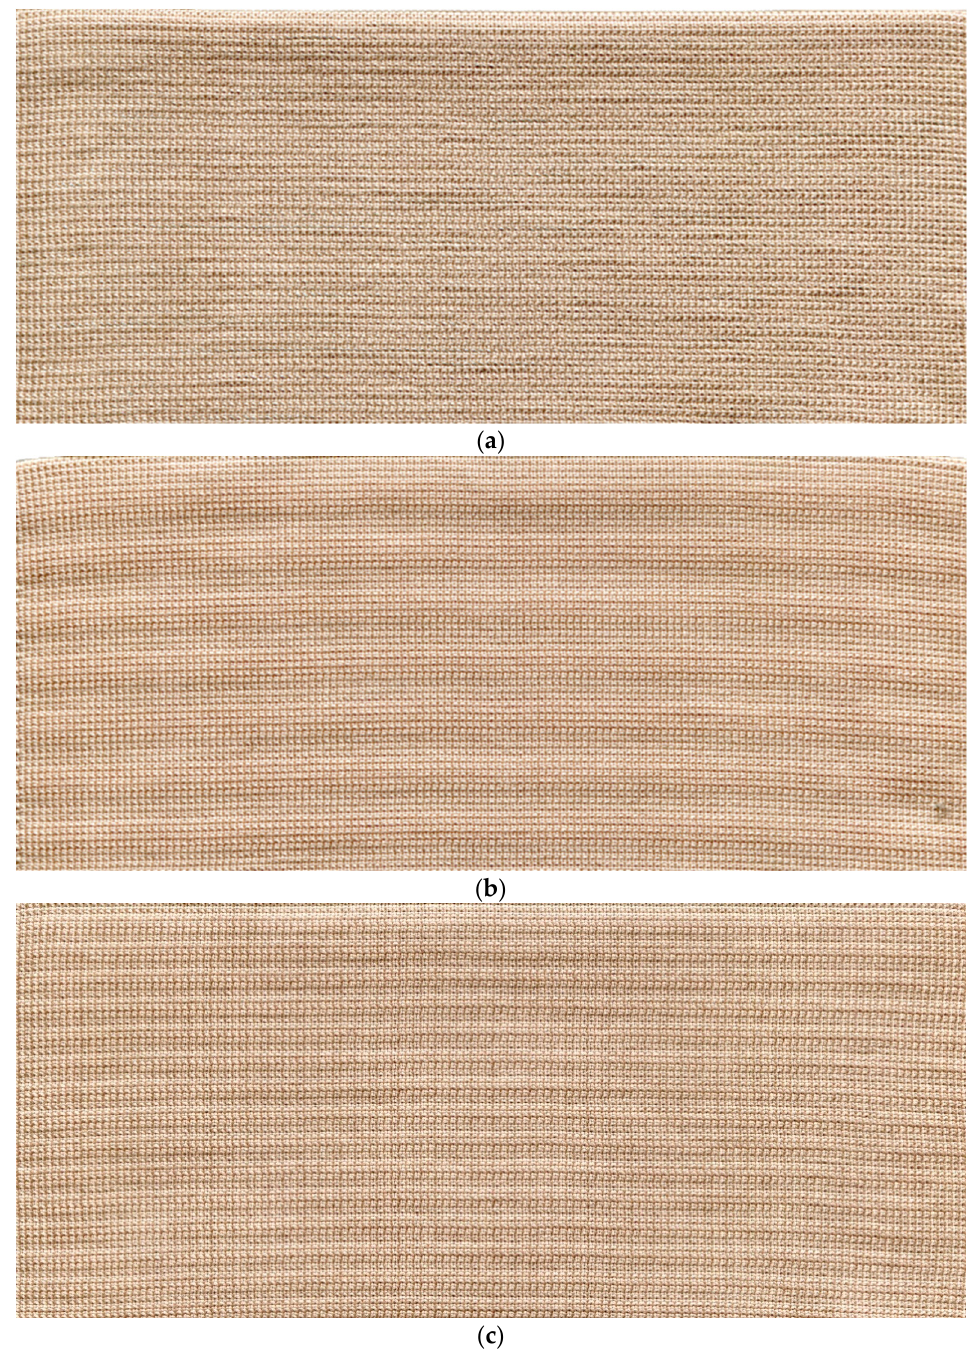
Figure 5. Snapshots of manufactured metal coated composite fabrics (left to right side indicates the course direction): ( a ) CF_LY1 and CF_HY1; ( b ) CF_LY2 and CF_HY2; and ( c ) CF_LY3 and CF_HY3.